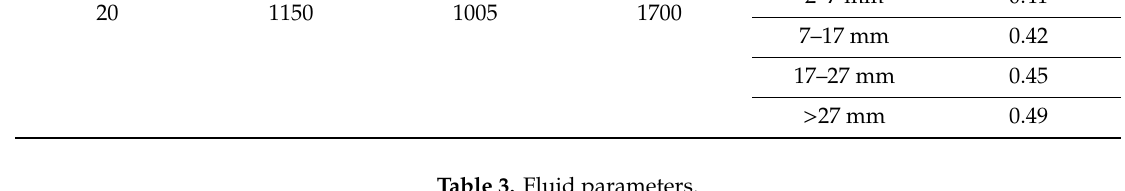
Table 3. Fluid parameters.